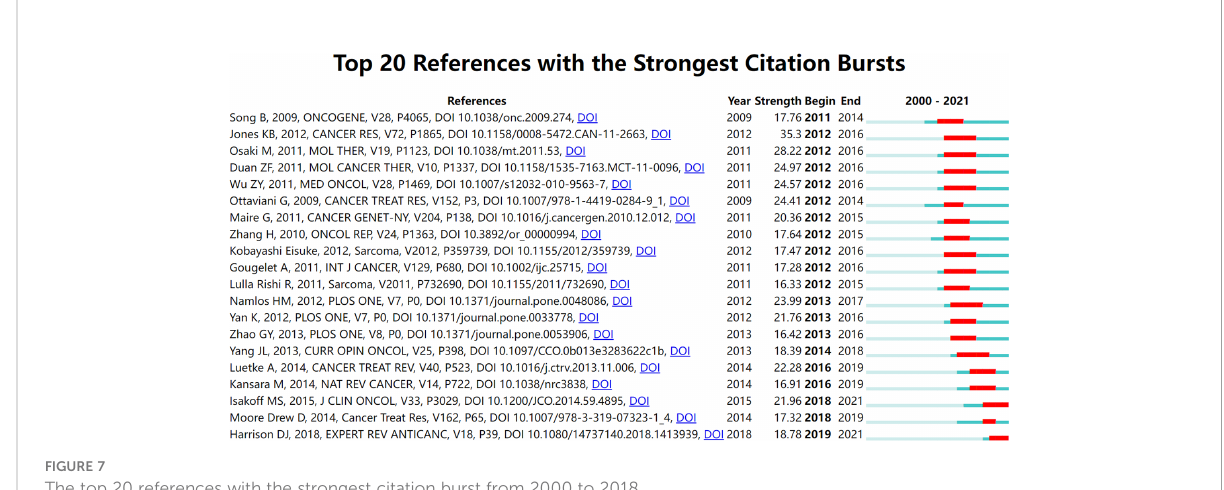
FIGURE 7 The top 20 references with the strongest citation burst from 2000 to